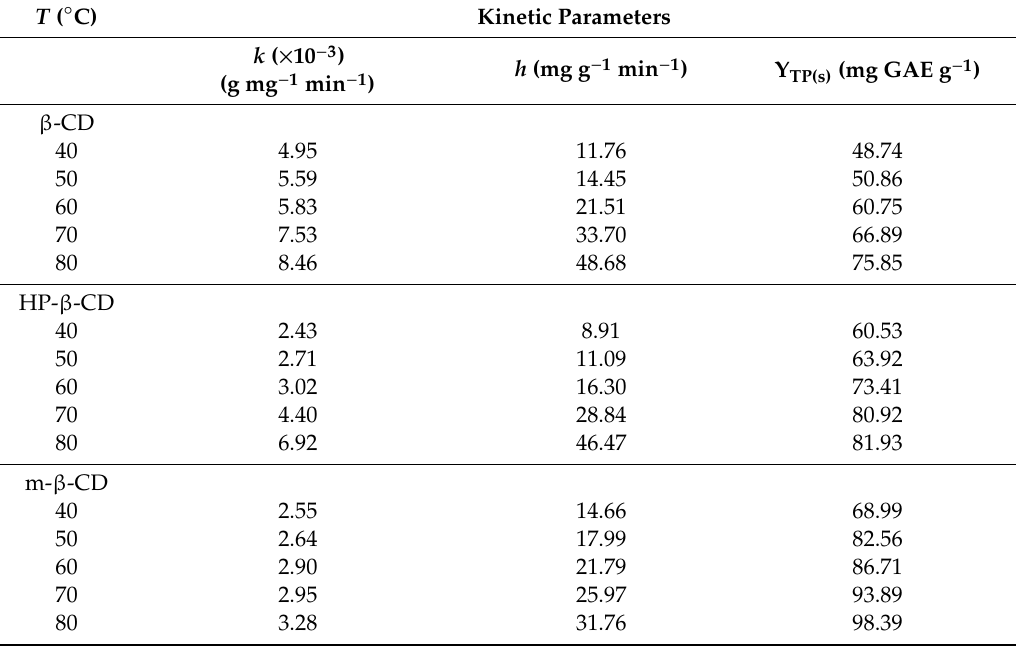
Table 7. Kinetic parameters determined for the extraction of S. fruticosa polyphenols with the CDs tested. Extractions were accomplished under optimal C CD , R L / S , and